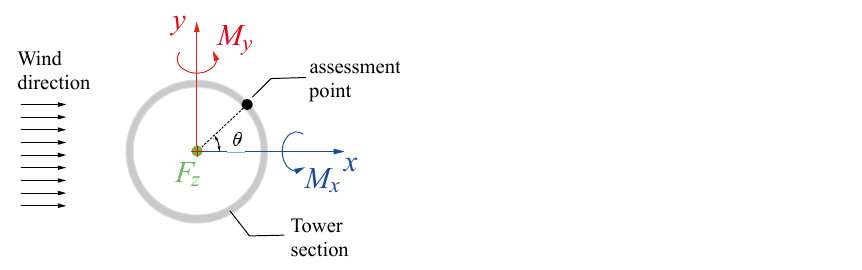
Figure 11. Time − varying tower − base bending moments under the extreme condition with and without considering the second − order wave excitations.